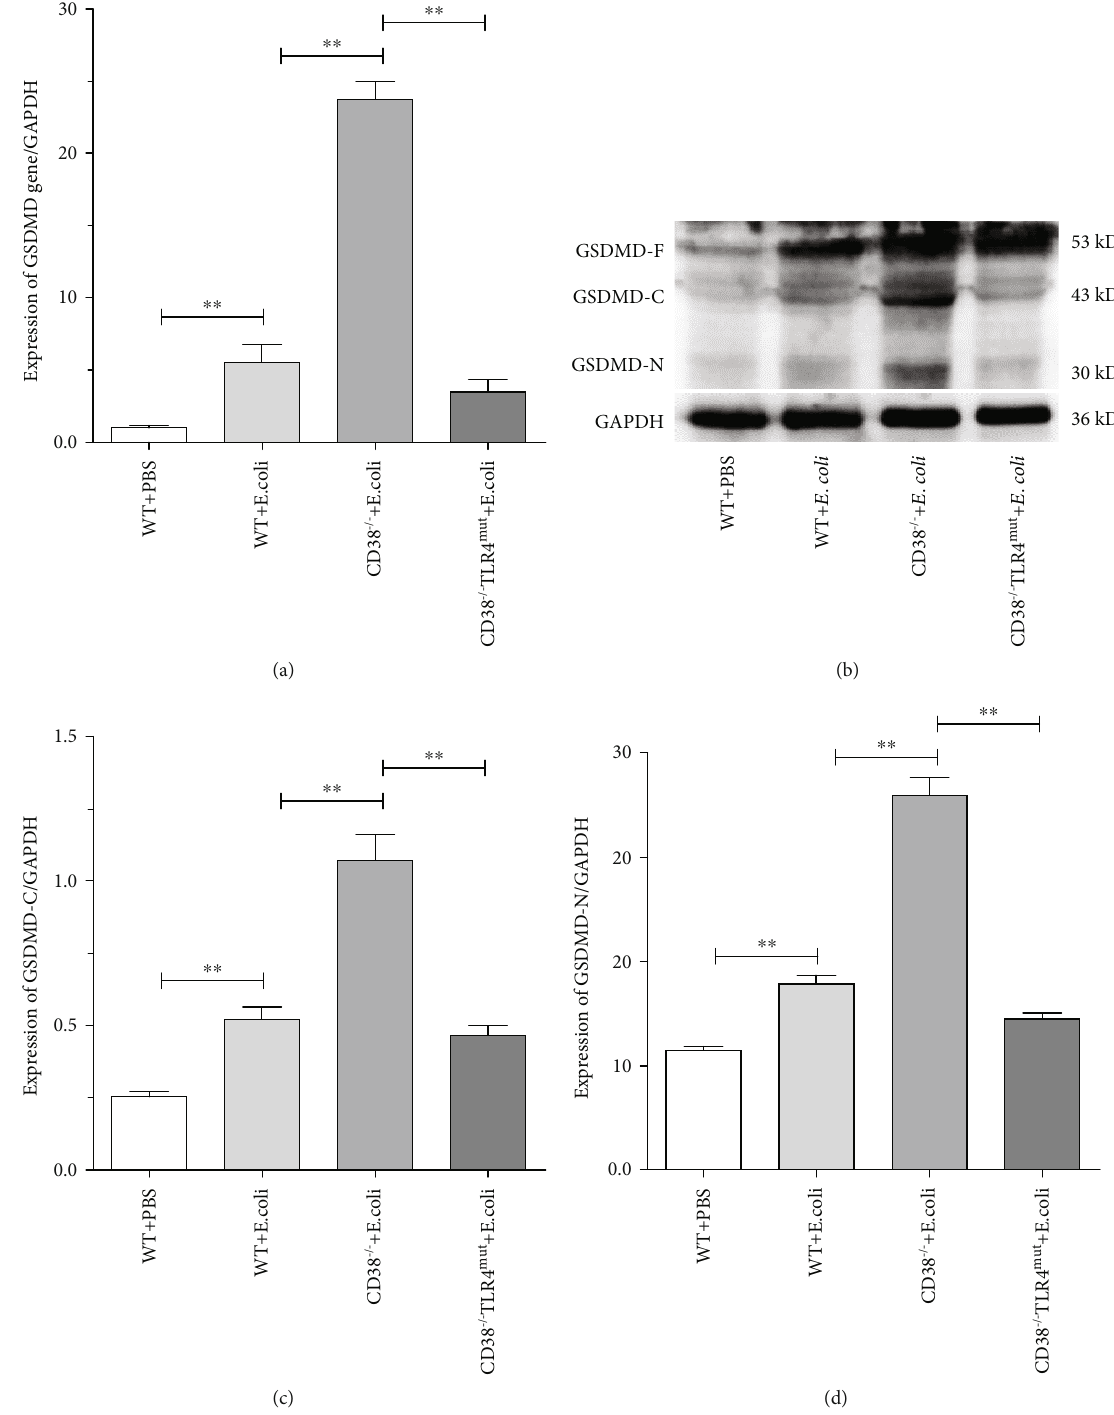
Figure 6: The expression of GSDMD was detected by Western blot. The expressions of GSDMD in the liver of WT, CD38 -/- , and CD38 -/- TLR4 mut mice were detected at 3 hours after E. coli stimulation. The mRNA expression of GSDMD was measured (a) by RT-qPCR. And the expression of GSDMD was detected (b) by Western blot. And relative levels of GSDMD-C to GAPDH (c) and GSDMD-N to GAPDH (d) were analyzed by ImageJ software. Data are presented as means ± standard deviation . Statistical signi fi cance was determined by one-way ANOVA ( n = 3 , ∗∗ p < 0 : 01